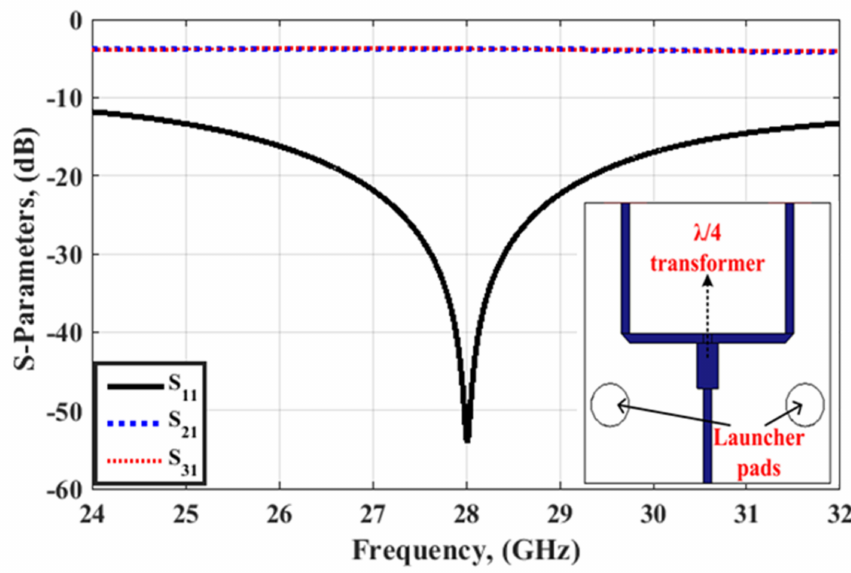
Figure 3. Geometry and S-parameters of the T-power divider for array feeding. A 1 × 2 antenna array is developed depending on the previous antenna. The spacing between the elements is 8 mm, which is equal to 0.746 λ 0 at a frequency of 28 GHz. The two elements are excited through a T-power divider that is presented earlier, as displayed in Figure 4. Figure 5 shows the reflection coefficient and gain characteristics of the proposed 1 × 2 array. The achieved frequency band (for |S 11 | < − 10 dB) is 26.35–30.15 GHz (3.8 GHz bandwidth) for the new radio band of 5G communications. The 1 × 2 array provides gain, directivity, and radiation efficiency values as 7.73 dBi, 8.06 dBi, and 92.68 %, respectively, at 28 GHz.